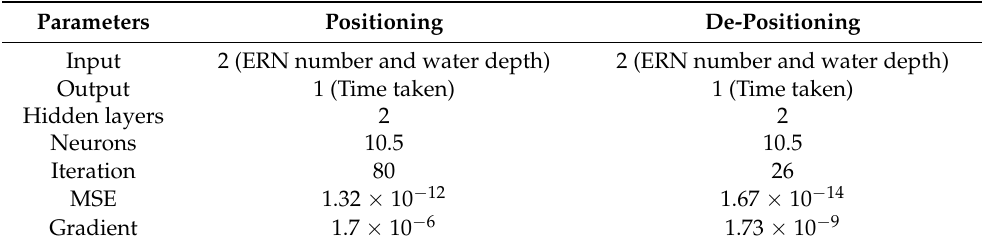
Table 10. Parameters of the trained ANN for the time taken to set up and remove the SM system. Parameters